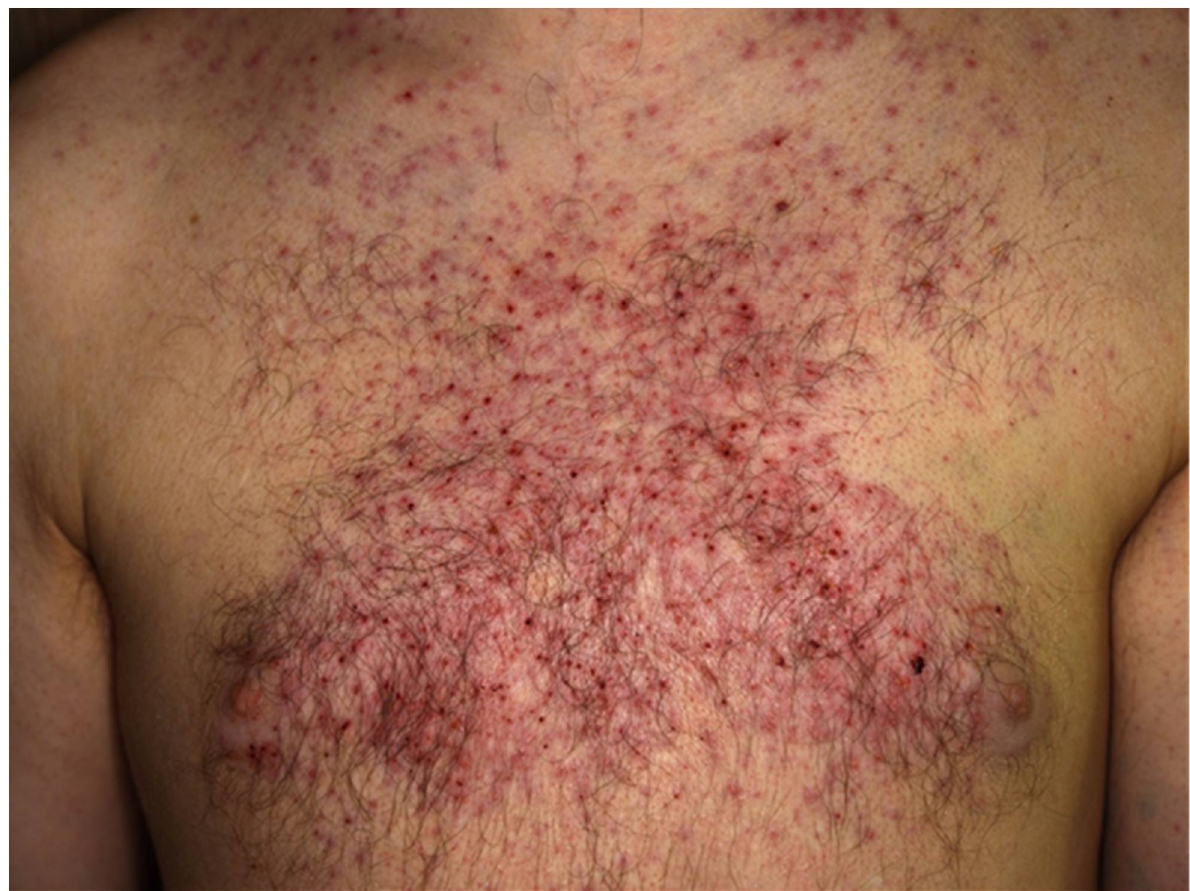
Figure 4. Widespread acneiform rash developing 2 months after the initiation of anti-BRAF plus anti-MEK combination therapy in a 33-year-old male with metastatic melanoma.